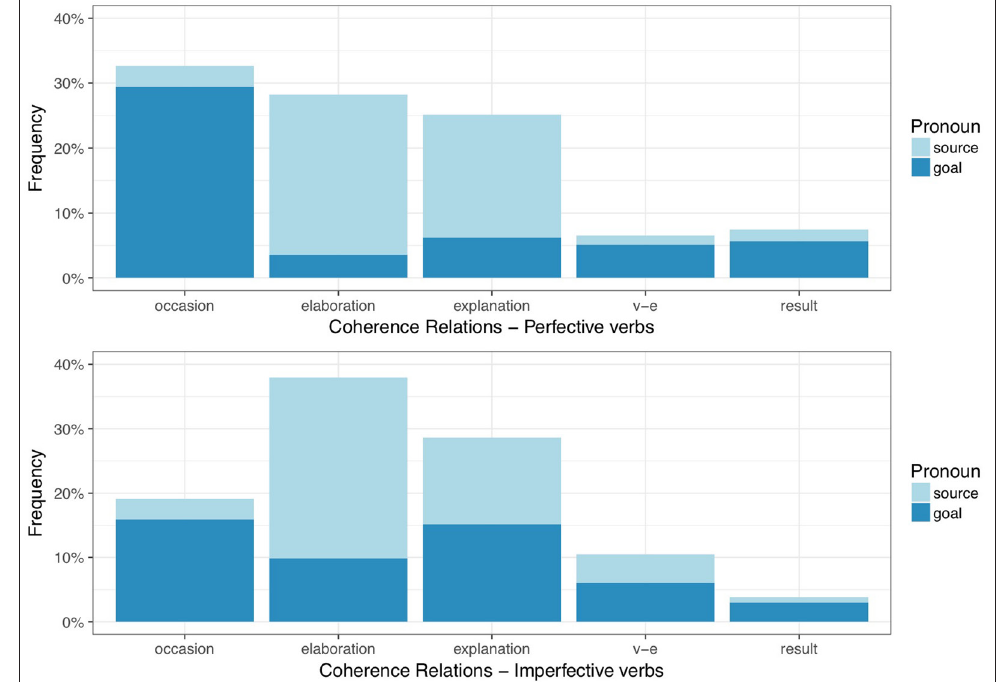
Figure 3: Effects of aspect on coherence relation distributions and pronoun